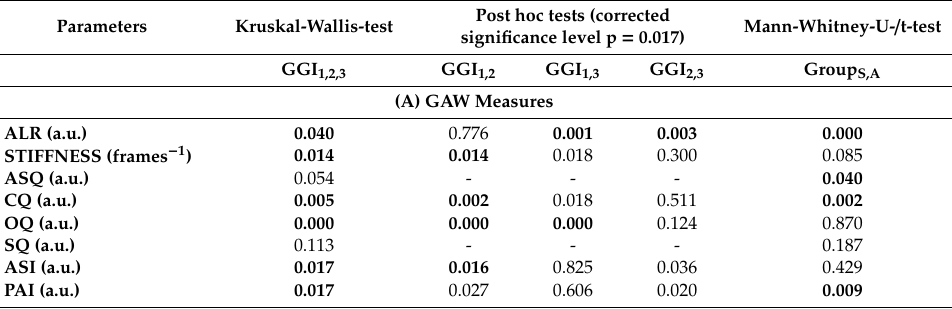
Table 4. Statistical results for the GAW, aerodynamic, and harmonic parameters.